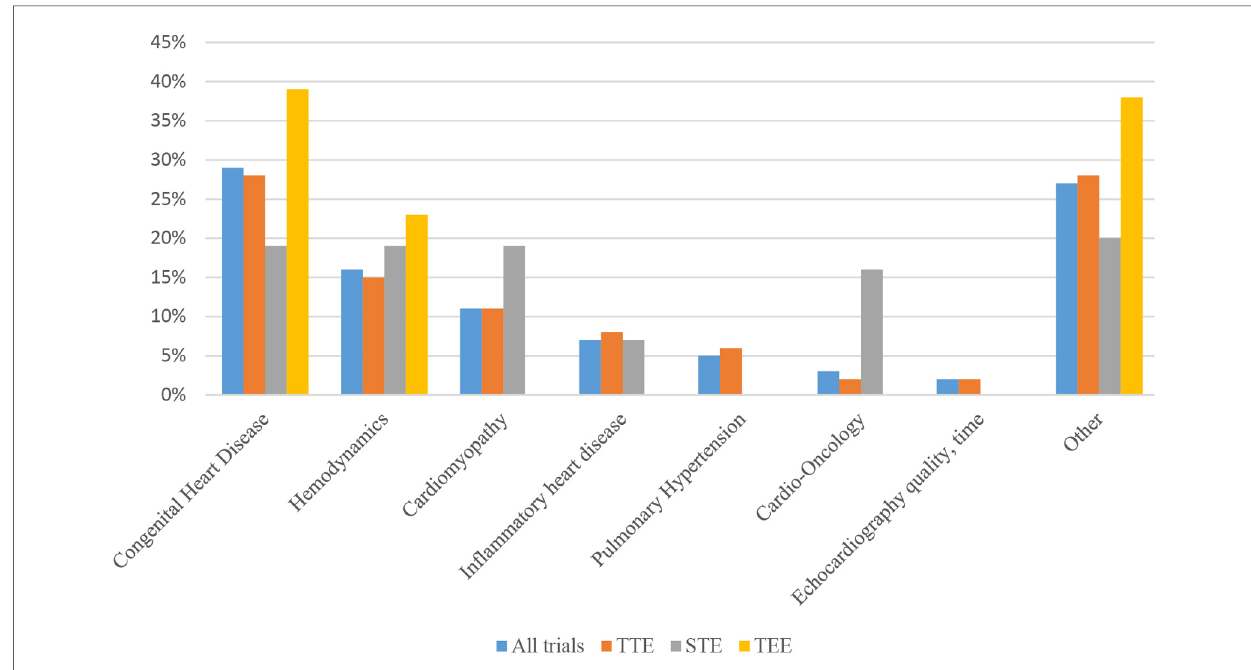
FIGURE 3 Comparison of application categories between different echocardiography